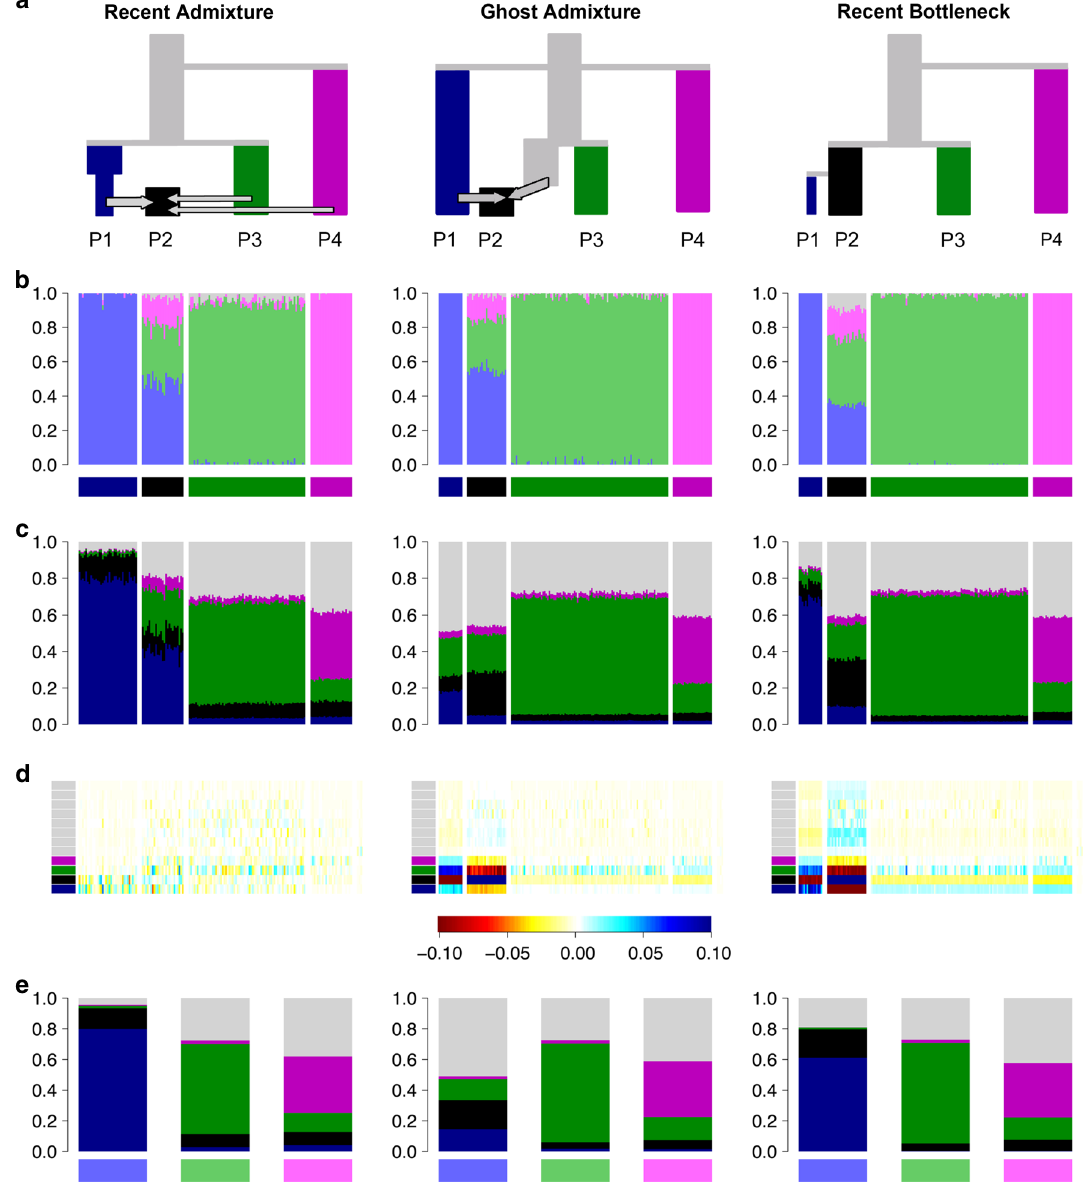
Fig. 2 Three scenarios that give indistinguishable ADMIXTURE results. a Simpli fi ed schematic of each simulation scenario. b Inferred ADMIXTURE plots at K = 11. c CHROMOPAINTER inferred painting palettes. d Painting residuals after fi tting optimal ancestral palettes using badMIXTURE, on the residual scale shown. e Ancestral palettes estimated by badMIXTURE. 13 populations in total were simulated, with grey populations all being outgroups to those shown in